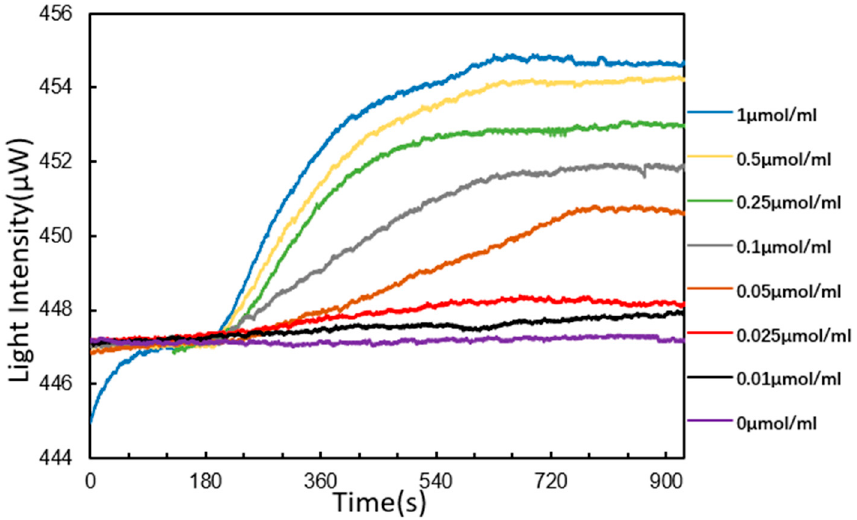
Figure 8. Reaction curves of DNA hybridization detection.